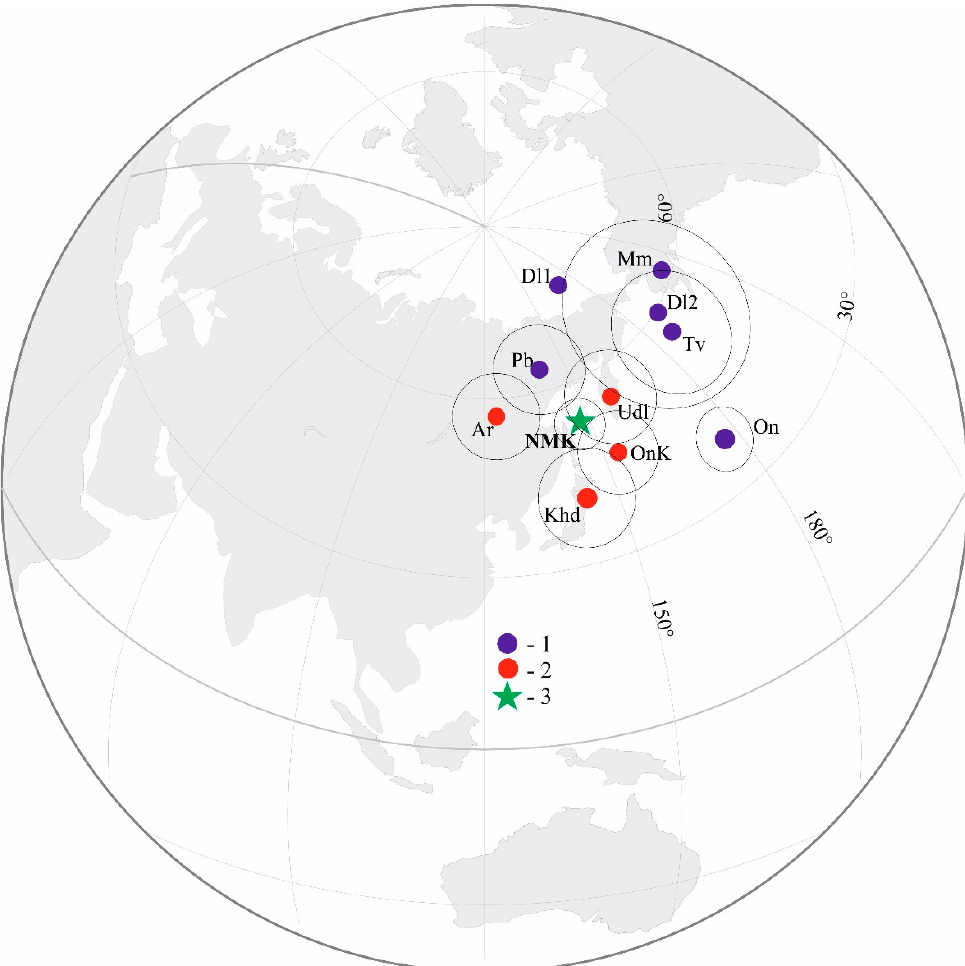
Figure 7. Position of mean virtual geomagnetic poles for the studied formations (stratigraphic Figure7. Positionofmeanvirtualgeomagneticpolesforthestudiedformations(stratigraphiccoordinate coordinate system). (1)—this study: Pb—Pravoboyarsky; On—Onkuchaksky; Tv—Tyvankitsky; system). (1)—this study: Pb—Pravoboyarsky; On—Onkuchaksky; Tv—Tyvankitsky; Dl1—Lower Dl1—Lower Delkansky; Dl2—Upper Delkansky; Mm—Maymechinsky Formation. Confidence Delkansky; Dl2—Upper Delkansky; Mm—Maymechinsky Formation. Confidence circles for Dl1 circles for Dl1 and Mm poles are not shown. (2)—previously published poles: Ar—Arydzhangsky and Mm poles are not shown. (2)—previously published poles: Ar—Arydzhangsky Formation [33]; Formation [33]; On—Onkuchaksky Formation in the Kotuy river valley [33]; Udl—Ust-Delkan dike On—Onkuchaksky Formation in the Kotuy river valley [33]; Udl—Ust-Delkan dike complex [65]. complex [65]. (3)—paleomagnetic pole NMK [41]. (3)—paleomagnetic pole NMK